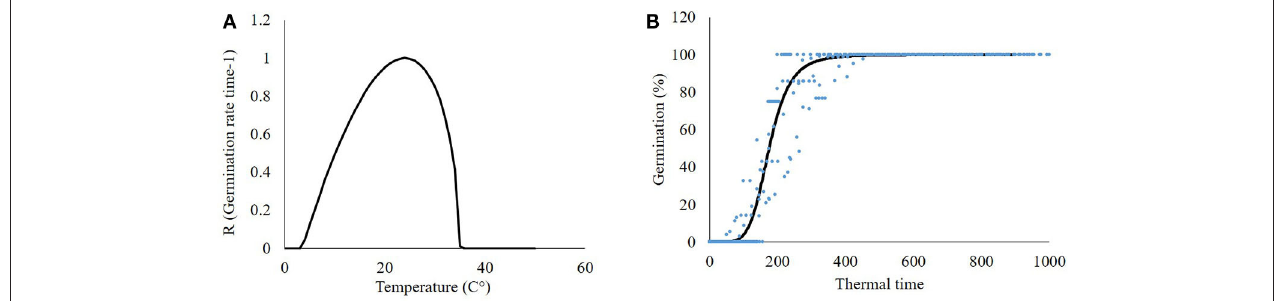
FIGURE 4 | Seedlings emergence of Parthenium hysterophorus seeds sown in different soil depths: 0, 1, 2, 3, 4, and 5cm ( A–F , respectively). Coefficient data are given in Table 2 .